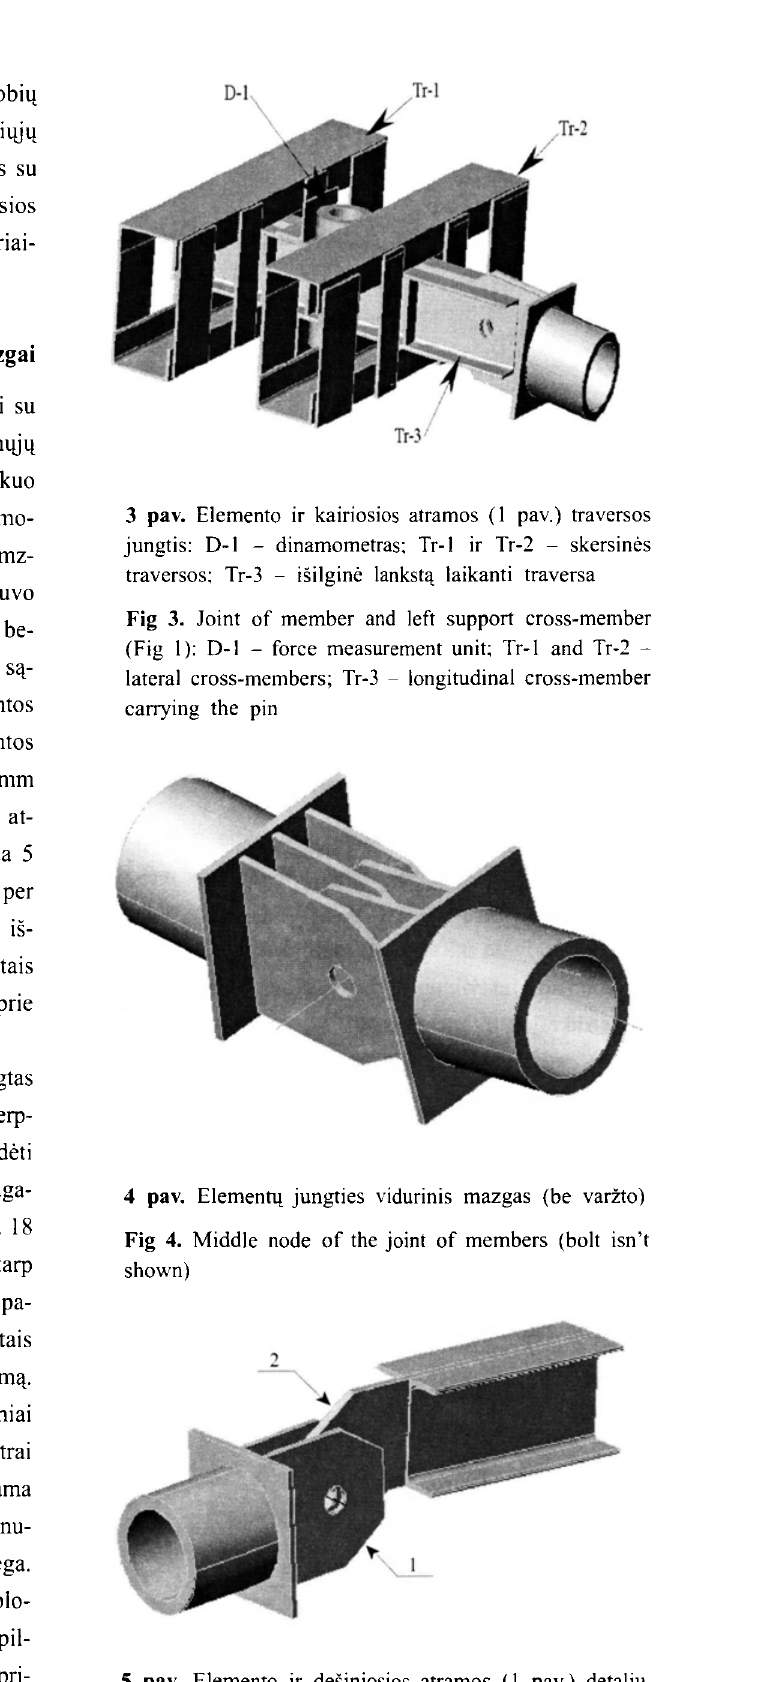
5 pav. Elemento ir desiniosios atramos (I pav.) detalitt jungtis: I - traversa; 2 - jos lanksto laikiklis Fig 5. Joint of member and right support (Fig I) details I ·- cross-member; 2 - its pin